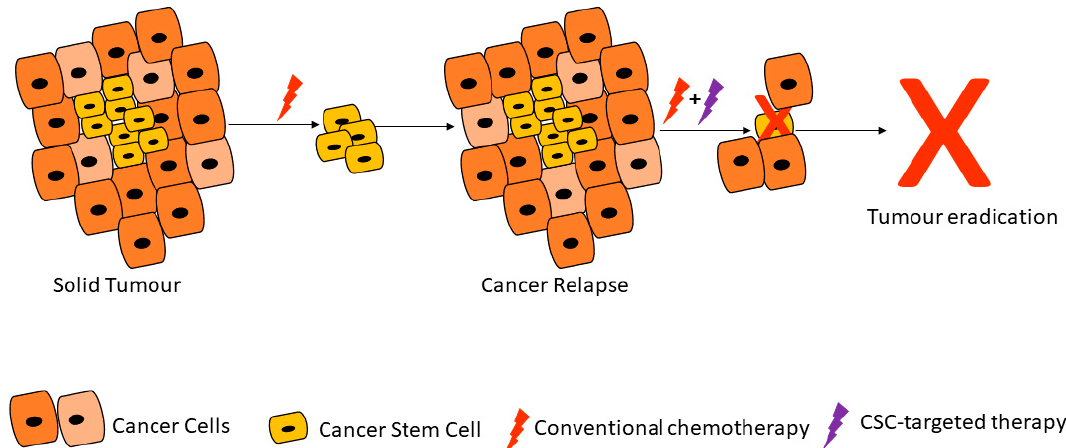
Figure 1. Cancer stem cells are able to resist conventional therapies and form new tumors, unless targeted by cancer stem cell (CSC)-specific therapy. Adapted from Dzobo et al. [30].